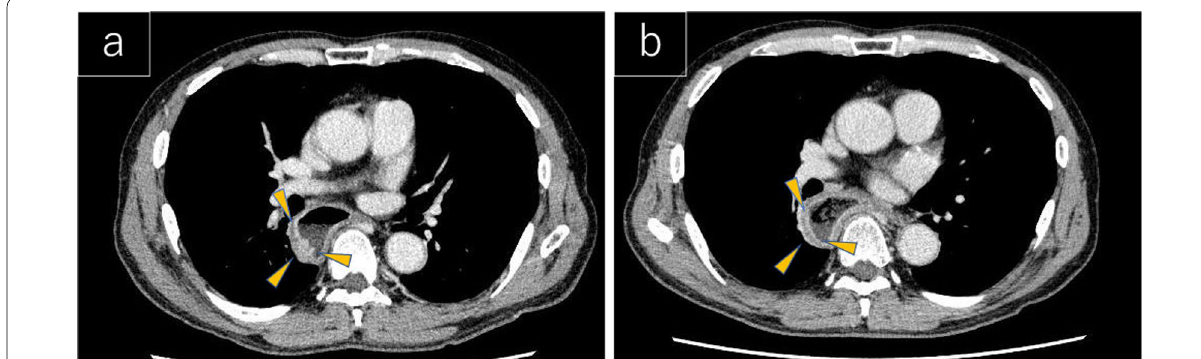
Fig. 2 Computed tomography images showing middle thoracic esophageal wall thickness (arrow head), a before neoadjuvant chemotherapy and b immediately before